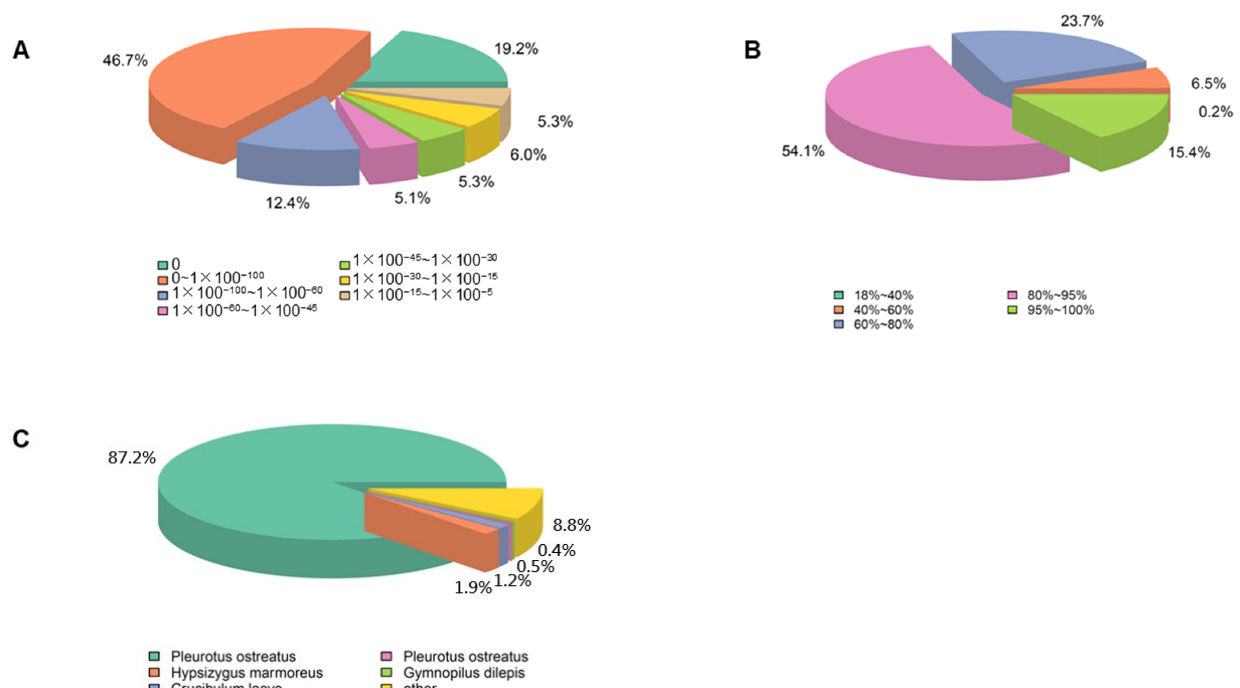
Figure 2. Alignment statistics. ( A ) E-value distribution; ( B ) similarity distribution; ( C ) species distribution.